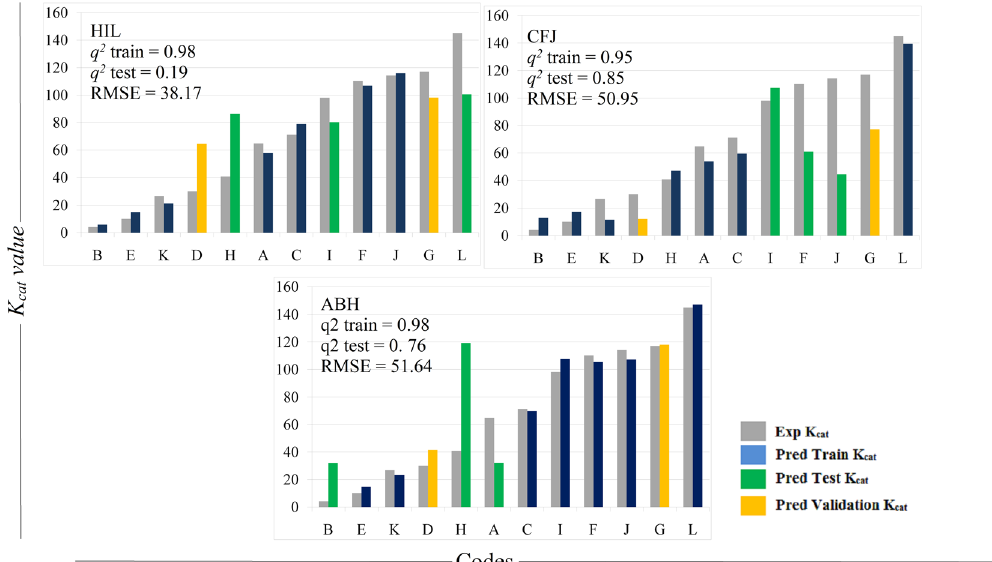
Figure 5. Analysis of the predicted activity values generated using PLS models derived from 19764 IEDs chosen based on the r value > 0.4. Graph shows the experimental vs. predicted activity values; training sets containing 7 codes (blue), test sets containing 3 codes (green); external validation set containing 2 codes (orange) and the respective experimental values (grey). The models sorted based on the least RMSD values of the training and the test set were used to predict the activity of the validation set (Table S13). These models showed impressive q2 values but the RMSE values of the test set were relative higher than that of the previously obtained models.